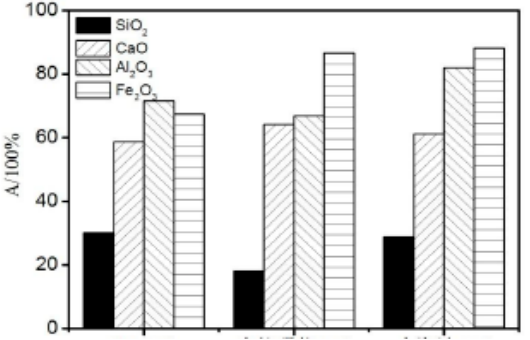
ff erent oxides and three di ff erent asphalts Figure 5. Adhesion among four different oxides and three different asphalts [34]. Figure 5. Adhesion among four di